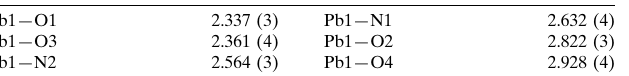
Selected bond lengths (A˚ ).